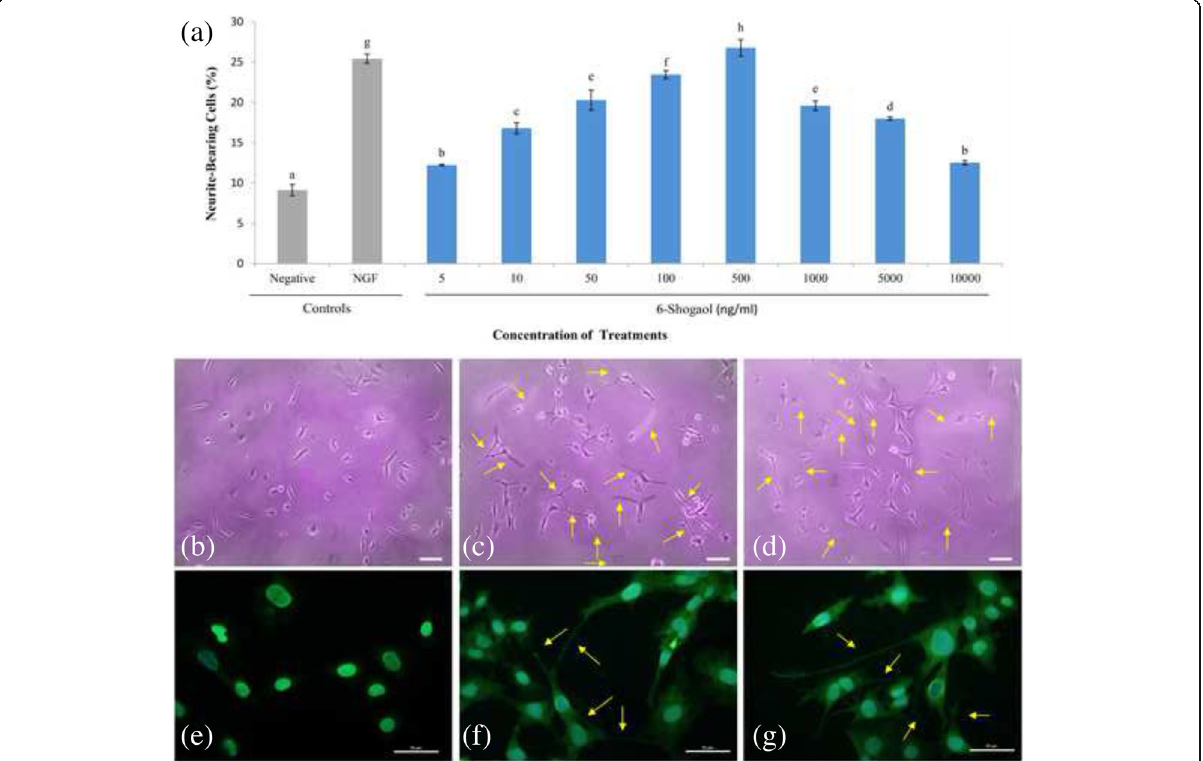
Fig. 4 Neuritogenic effect of 6-shogaol in PC-12 cells. a Percentage of neurite-bearing cells after 48 h of incubation with NGF (50 ng/ml) (positive control) or 6-shogaol (5 to 10,000 ng/ml). Cells in complete F-12 K medium served as a negative control. Data were expressed as means ± SD from three independent experiments carried out in triplicates. Means with different alphabets show significant differences ( p < 0.05). Phase contrast photomicrographs of PC-12 cells: ( b ) in medium only; ( c ) treated with 50 ng/ml of NGF; ( d ) treated with 500 ng/ml of 6-shogaol. Scale bar = 20 μ m. Immunocytofluorescence staining of neurofilaments of PC-12 cells: ( e ) in medium only; ( f ) treated with 50 ng/ml of NGF; ( g ) treated with 500 ng/ml of 6-shogaol. Scale bar = 50 μ m. Arrows indicate neurite